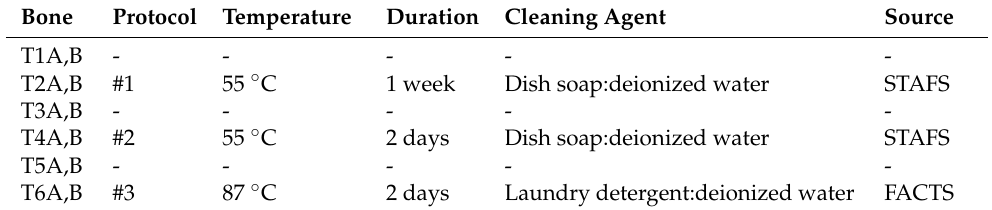
Table 1. Maceration protocols employed in the